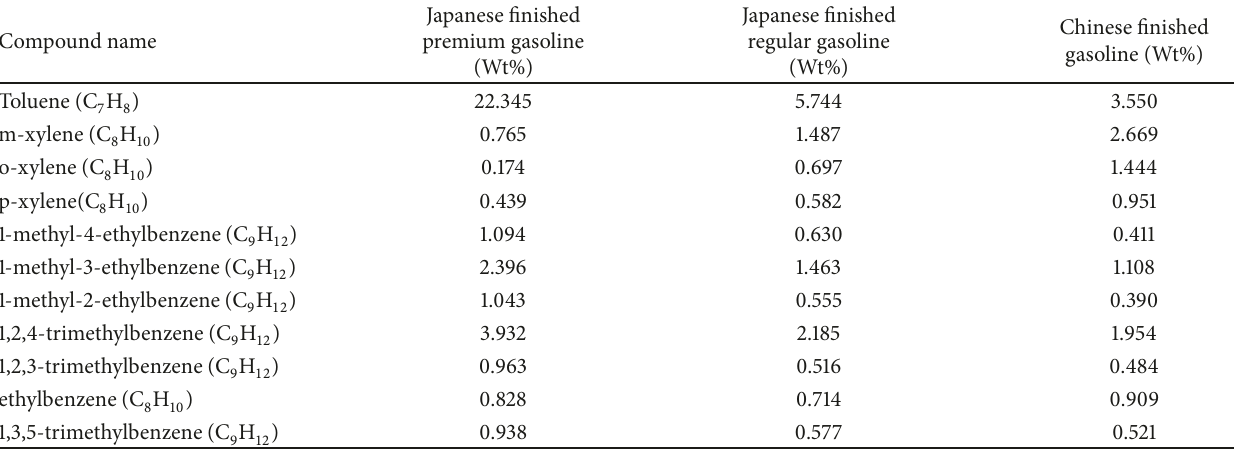
Figure 6: Ignition delay times of cyclohexane at equivalence ratio of 1 in the pressure range of 7-9 atm (right), 11-14 atm (left) from a RCM investigation and model-predicted values (line) at 8 atm (left) and 12.5 atm (right). Open symbols and dashed line correspond to cool flame delay times. Picture is adopted from Silke et al. [26]. Table 7: The major aromatic components in Chinese finished gasoline, Japanese finished regular gasoline, and Japanese finished premium gasoline, adopted from [135]. Part of the table is reported for component weight fraction higher than